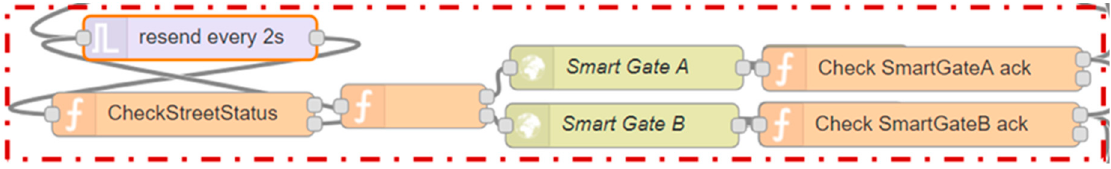
Figure 10. Second sub-flow that controls whether the road is marked as free and sends the "Access Allowed" message to the correct Smart Gate. The entire flow is shown in Figure 5.